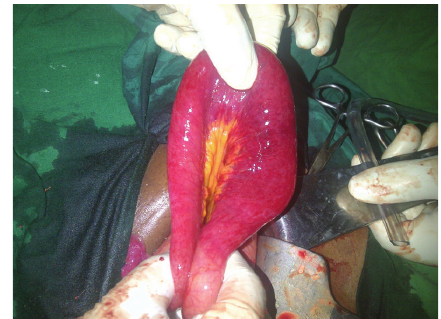
Figure 3: Herniated loop of small bowel.